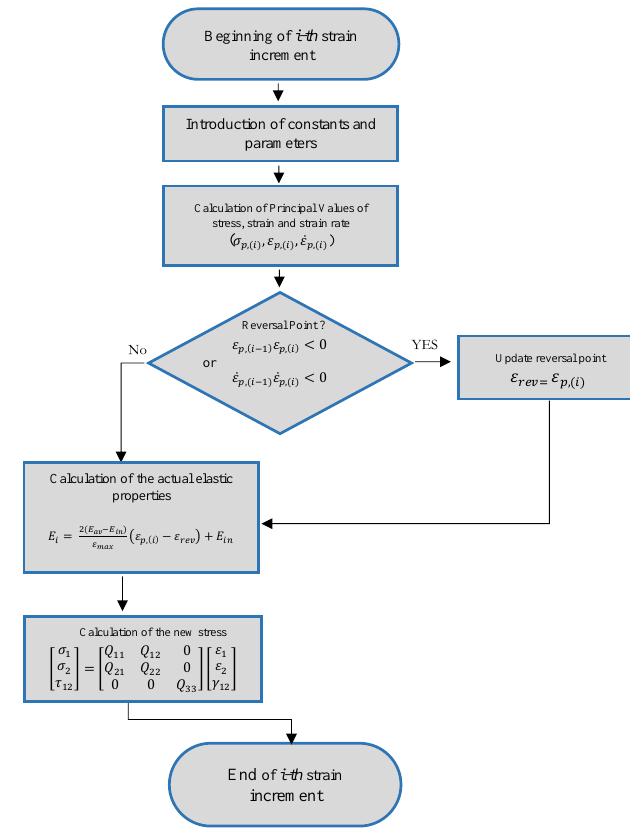
Figure 5. Flowchart of the SMA-UMAT.for